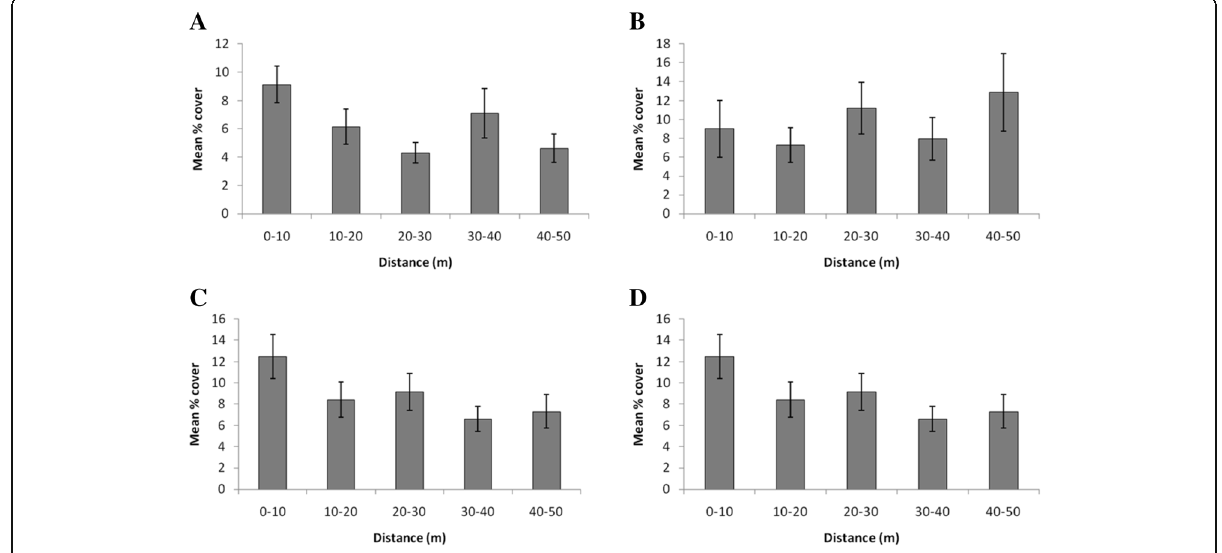
Fig. 3 Mean percentage cover variation with distance from surface water in Boro ( a ), Seronga ( b ), Jao ( c ), and UPH ( d